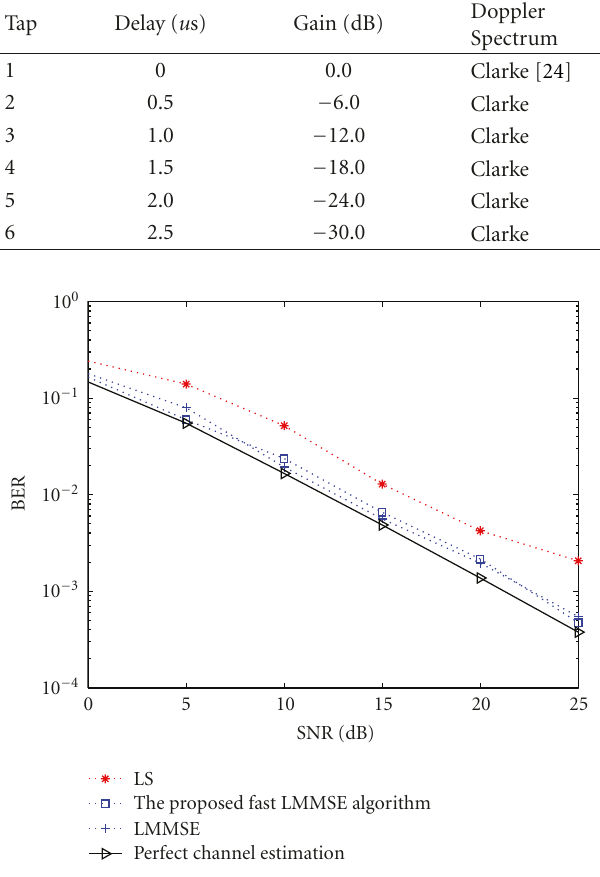
Figure 8: Bit error rate (BER) of the LS, LMMSE, the proposed fast LMMSE, and perfect channel estimation versus